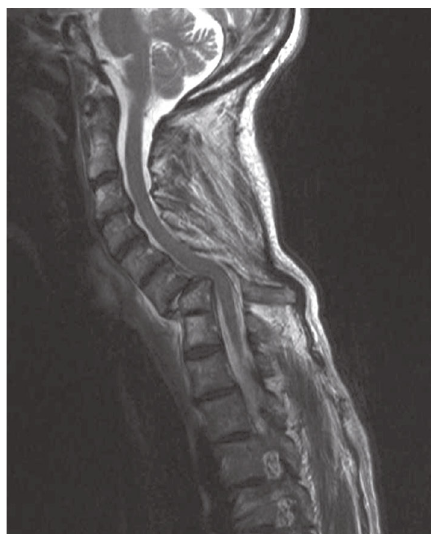
Figure 2: Preoperative MRI scan (sagittal cut).